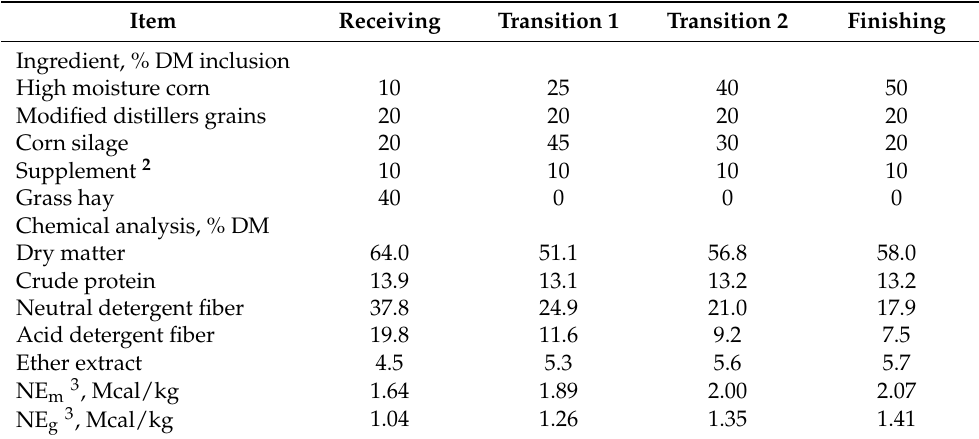
Table 2. Diet and nutrient composition during receiving, adaptation, and finishing phase